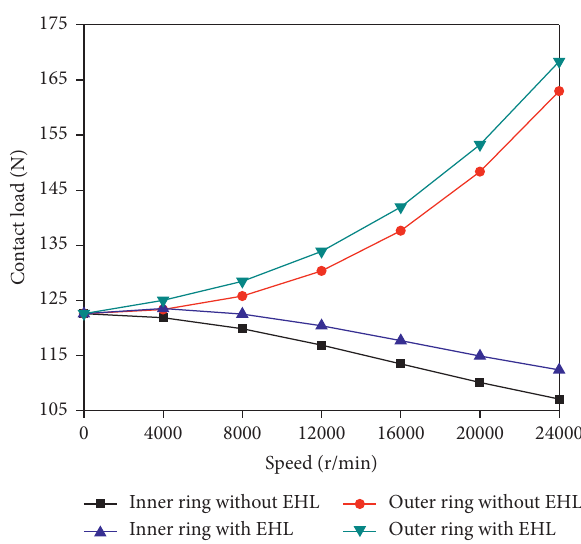
Figure 13: Influences of the speed and EHL on contact